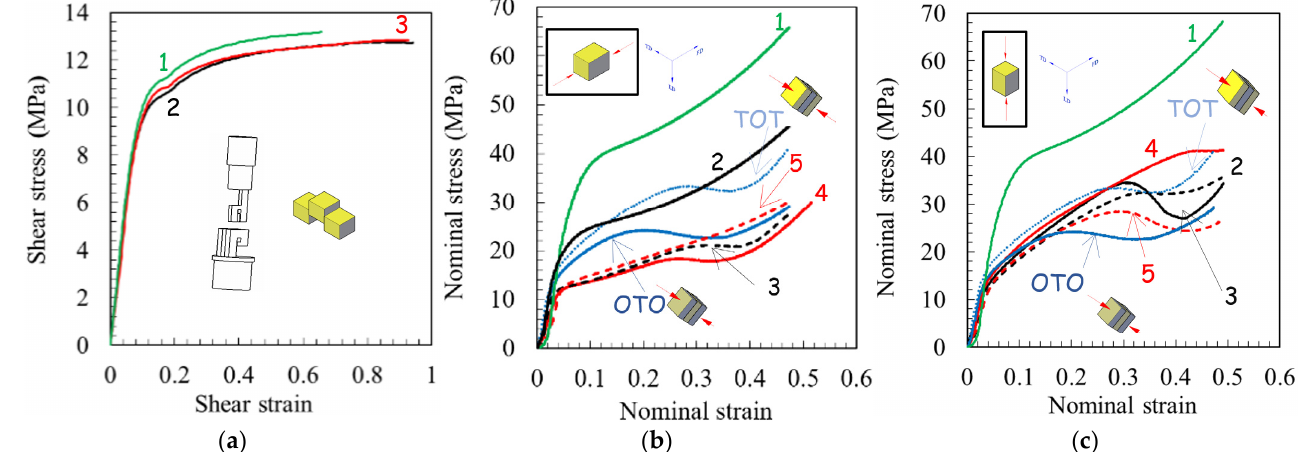
Figure 6. Shear and compressive results after first pass extrusion: ( a ) shear loading, ( b ) compression loading normal to longitudinal plane, and ( c ) compression loading normal to flow plane. One: as-received PP. Two: ram velocity of 45 mm/min and BP of 0 N. Three: ram velocity of 45 mm/min and BP of 900 N. Four: ram velocity of 4.5 mm/min and BP of 0 N. Five: ram velocity of 4.5 mm/min and BP of 900 N. OTO and TOT at ram velocity of 45 mm/min and BP of 0 N.